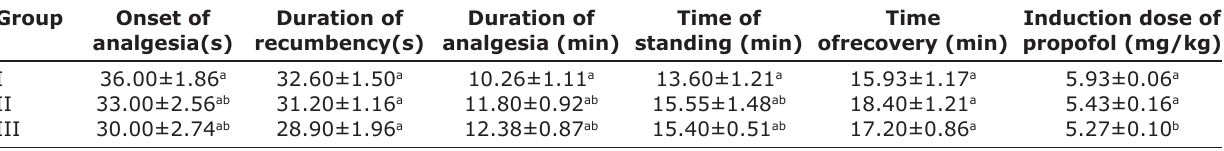
Table-4: Mean±SE value of anesthetic indices and induction dose of propofol of different groups. Group Onset of Duration of Duration of analgesia(s) recumbency(s) analgesia